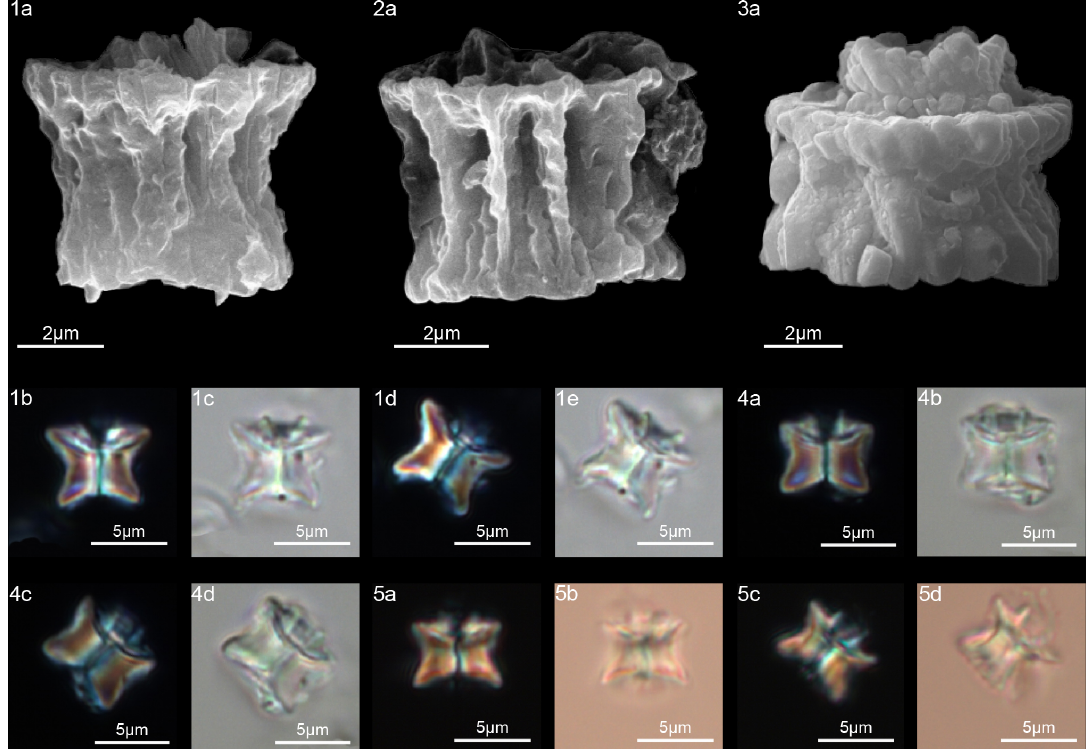
Figure 26. Fasciculithus vertebratoides . (1) Sample: 356Z 23R-1, 70–71. (1a) SEM, (1b, d) XPL, (1c, e) PPL. (2) Sample: 356-23R-1, 70–71. (2a) SEM. (3) Sample: 1262C 10-6, 23–24. (3a) SEM. (4) Sample: 119 37-4, 40–41. (4a, c) XPL, (4b, d) PPL. (5) Sample: 356Z 23R-1, 70–71. (5a, c) XPL, (5b, d) PPL. See Table S1 for sample details.